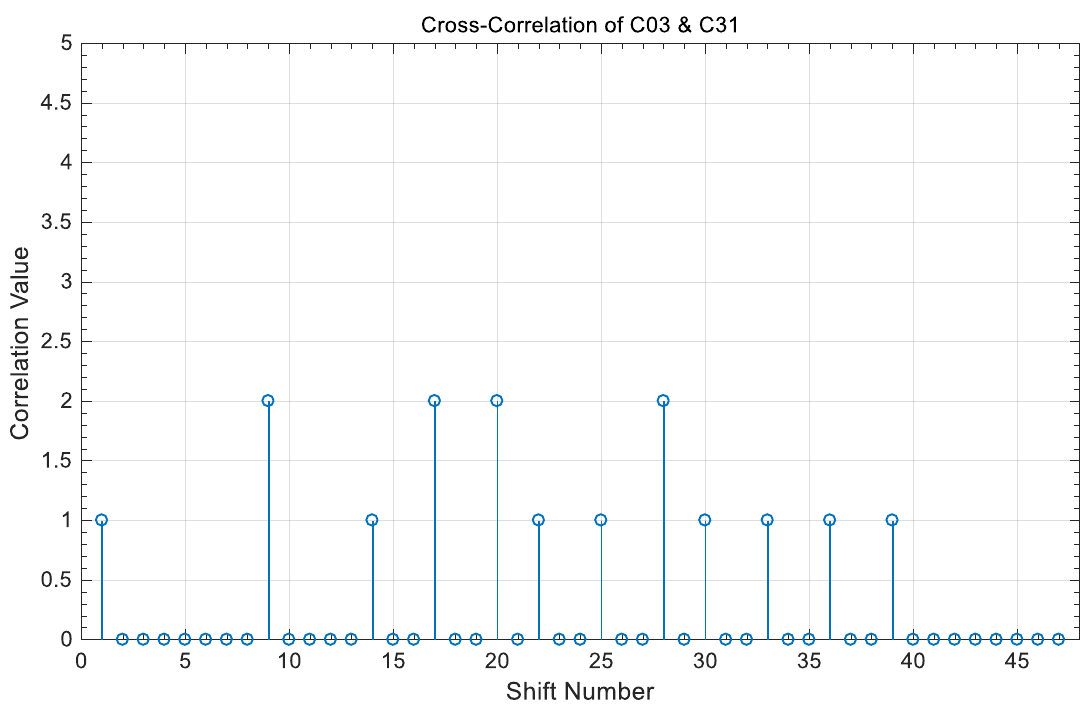
Figure 14. Cross-correlation between 𝐶 03 and 𝐶 31 sequences from different groups, 𝑃 1 = 5 and 𝑃 2 = 7.